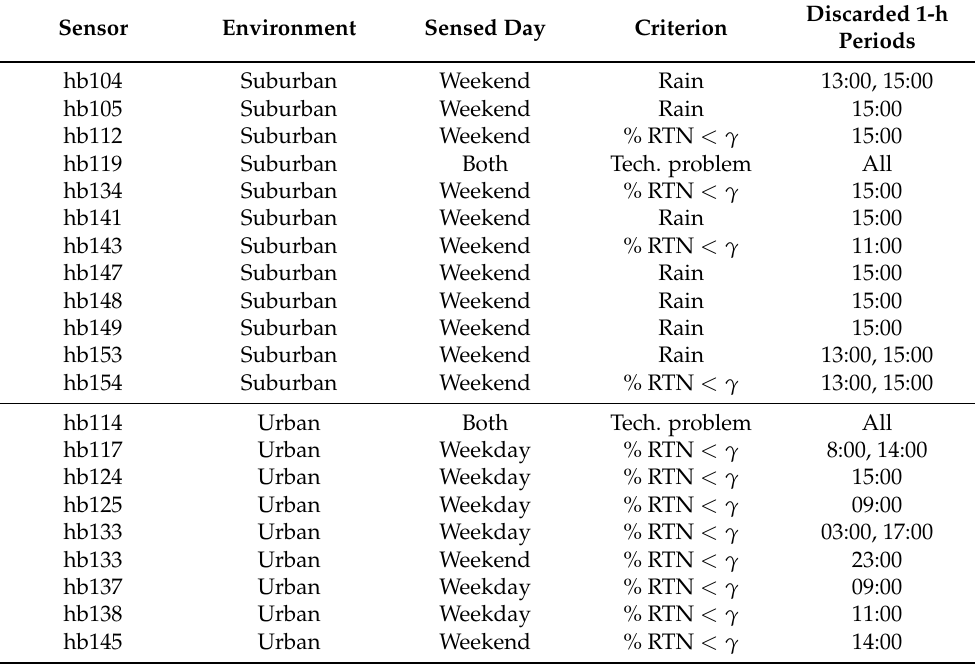
Table 1. Discarded 1-h periods from both suburban and urban